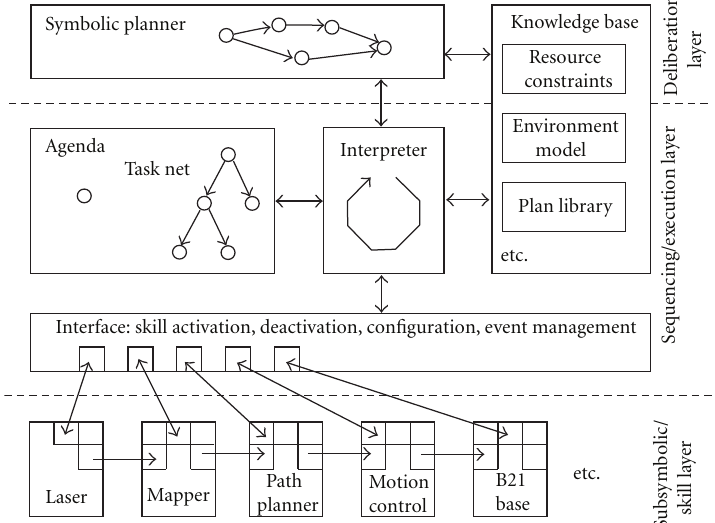
Figure 5: Smartsoft system architecture. (© (1999) IEEE) (reproduced from [67] with permission of Dr. Christian Schlegel).